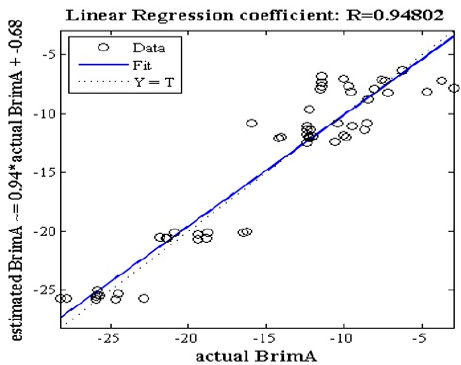
Figure 4. Regression analysis of the scatter plot between the estimated and the measured values of BrimA of the apples on the spectral range around the wavelength of 962 nm in the best training case.